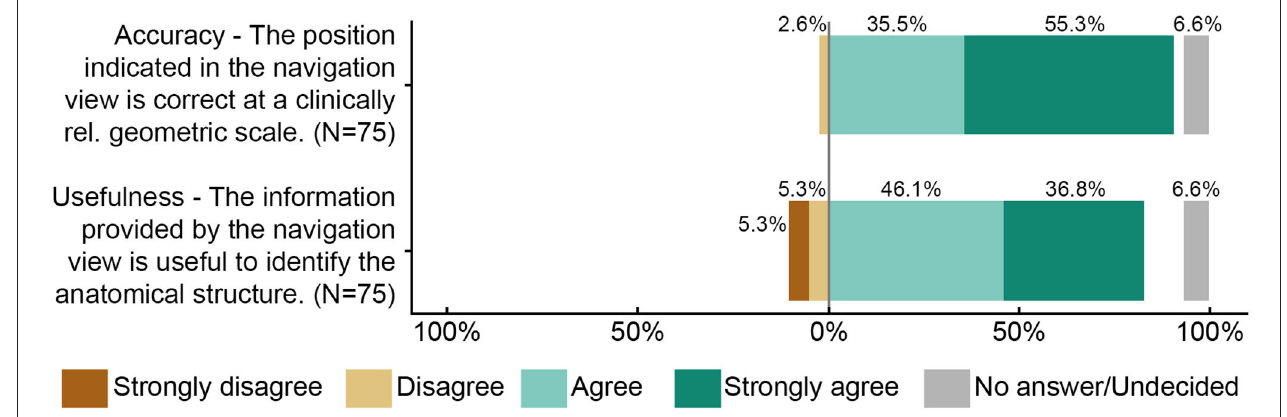
FIGURE 5 | Summary of the accuracy and usefulness ratings ( N = 75). Five surgeons each rated 15 anatomical landmarks from two study